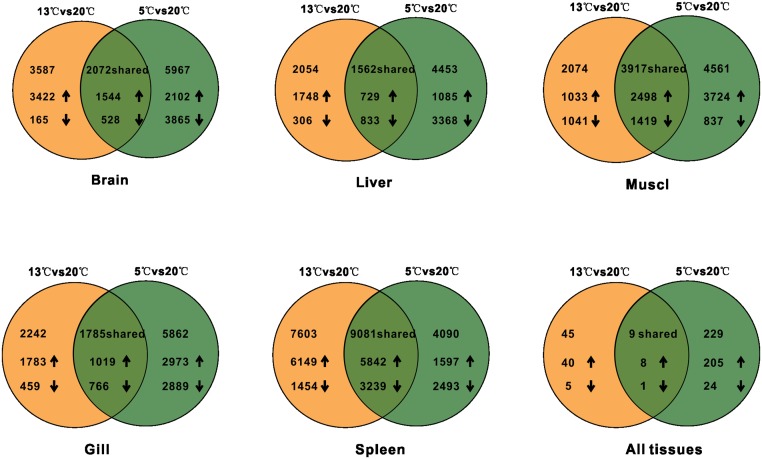
Global gene expression profiles of Amur carp.